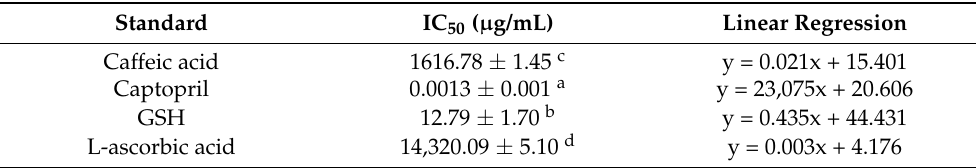
Table 1. The half-maximal inhibitory concentration (IC 50 ) of caffeic acid in comparison with captopril and blood plasma antioxidants for angiotensin-converting enzyme (ACE)